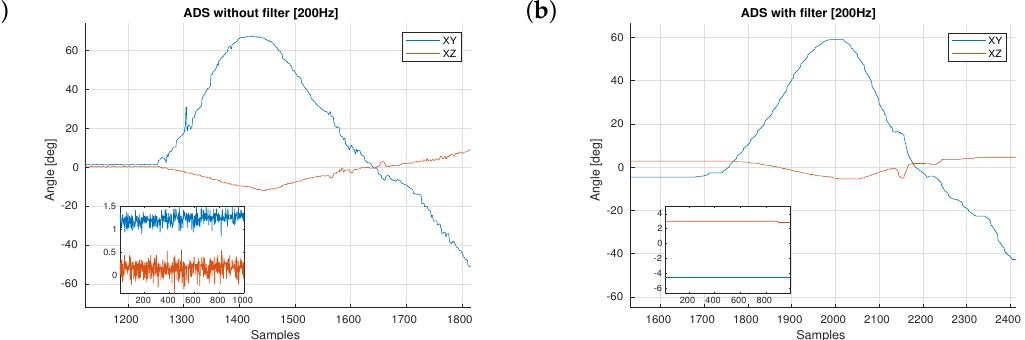
Figure 5. Example of similar gestures in two different takes. ( a ) First take shows the behaviour of the sensor without the filter. ( b ) Second take of a similar gesture shows the behaviour with the filter.